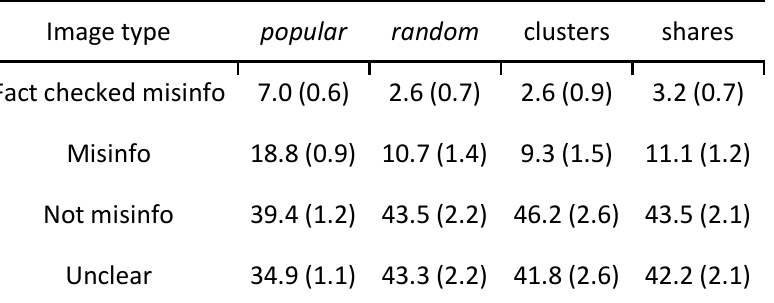
Table 1: Prevalence (%) of image types. The first two columns are for the two samples of labelled images. The second two use sampling weights to estimate prevalence in the population of all unique image clusters and the population of image shares. The latter uses post-stratification on percentiles of the number of times shared. Standard errors are given in parentheses .